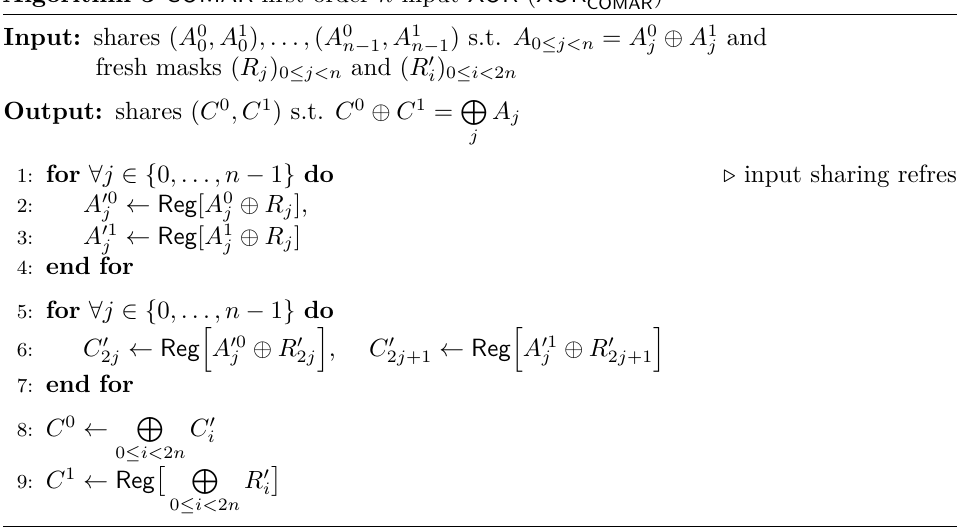
Algorithm 3 COMAR first-order n -input XOR ( XOR n